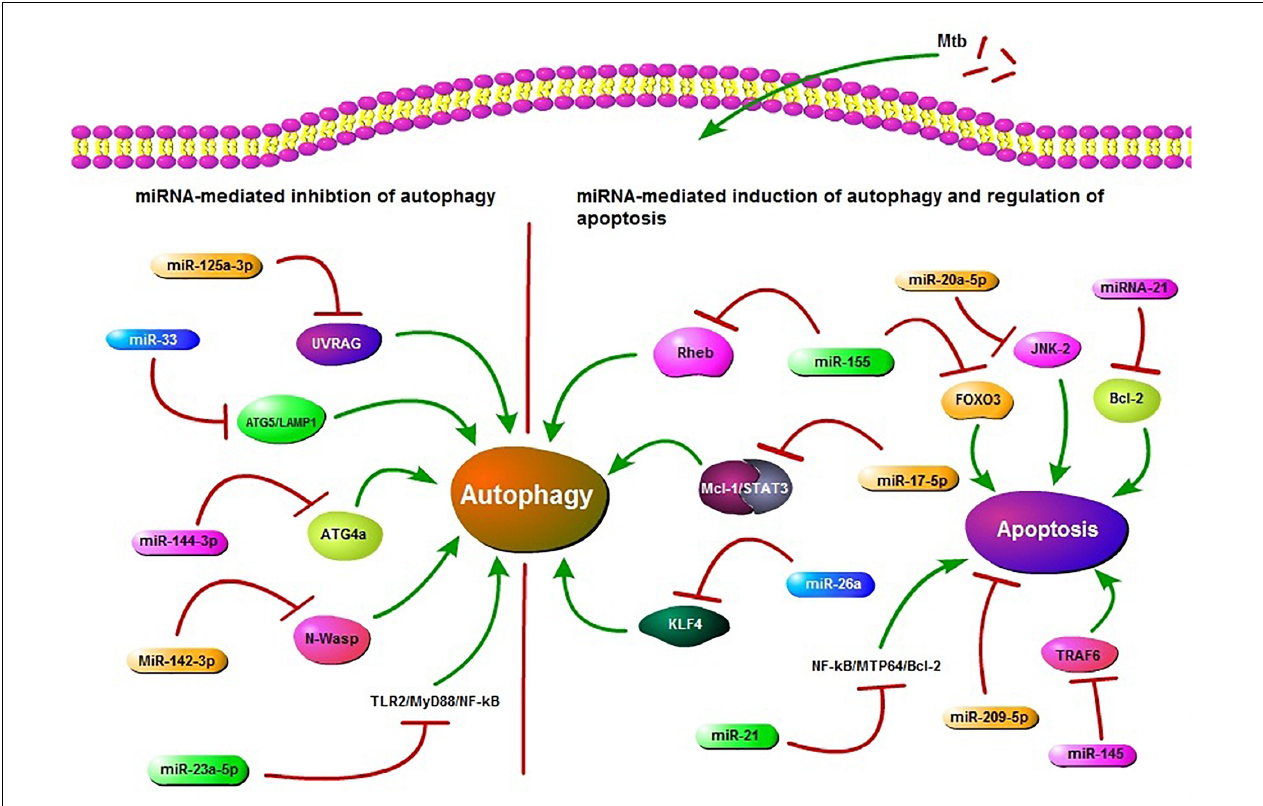
FIGURE 1 | Schematic presentation of miRNA regulation of autophagy and apoptosis. miR-125a-3p, miR-33, miR-144-3p, miR-23a-5p, and miR-142-3p are potential inhibitors of autophagy in Mycobacterium tuberculosis (Mtb) infection. miR-125a-3p inhibits autophagy through targeting UV radiation resistance-associated gene (UVRAG), miR-33 targets ATG5/LAMP1, miR-144-3p targets autophagy-related gene 4a (ATG4a), miR-23a-5p inhibits the TLR2/MyD88/NF- κ B leading to reduced autophagy and miR-33 also plays an inhibitory role via targeting some unknown factors. miR-142-3p targets Neural Wiskott-Aldrich syndrome